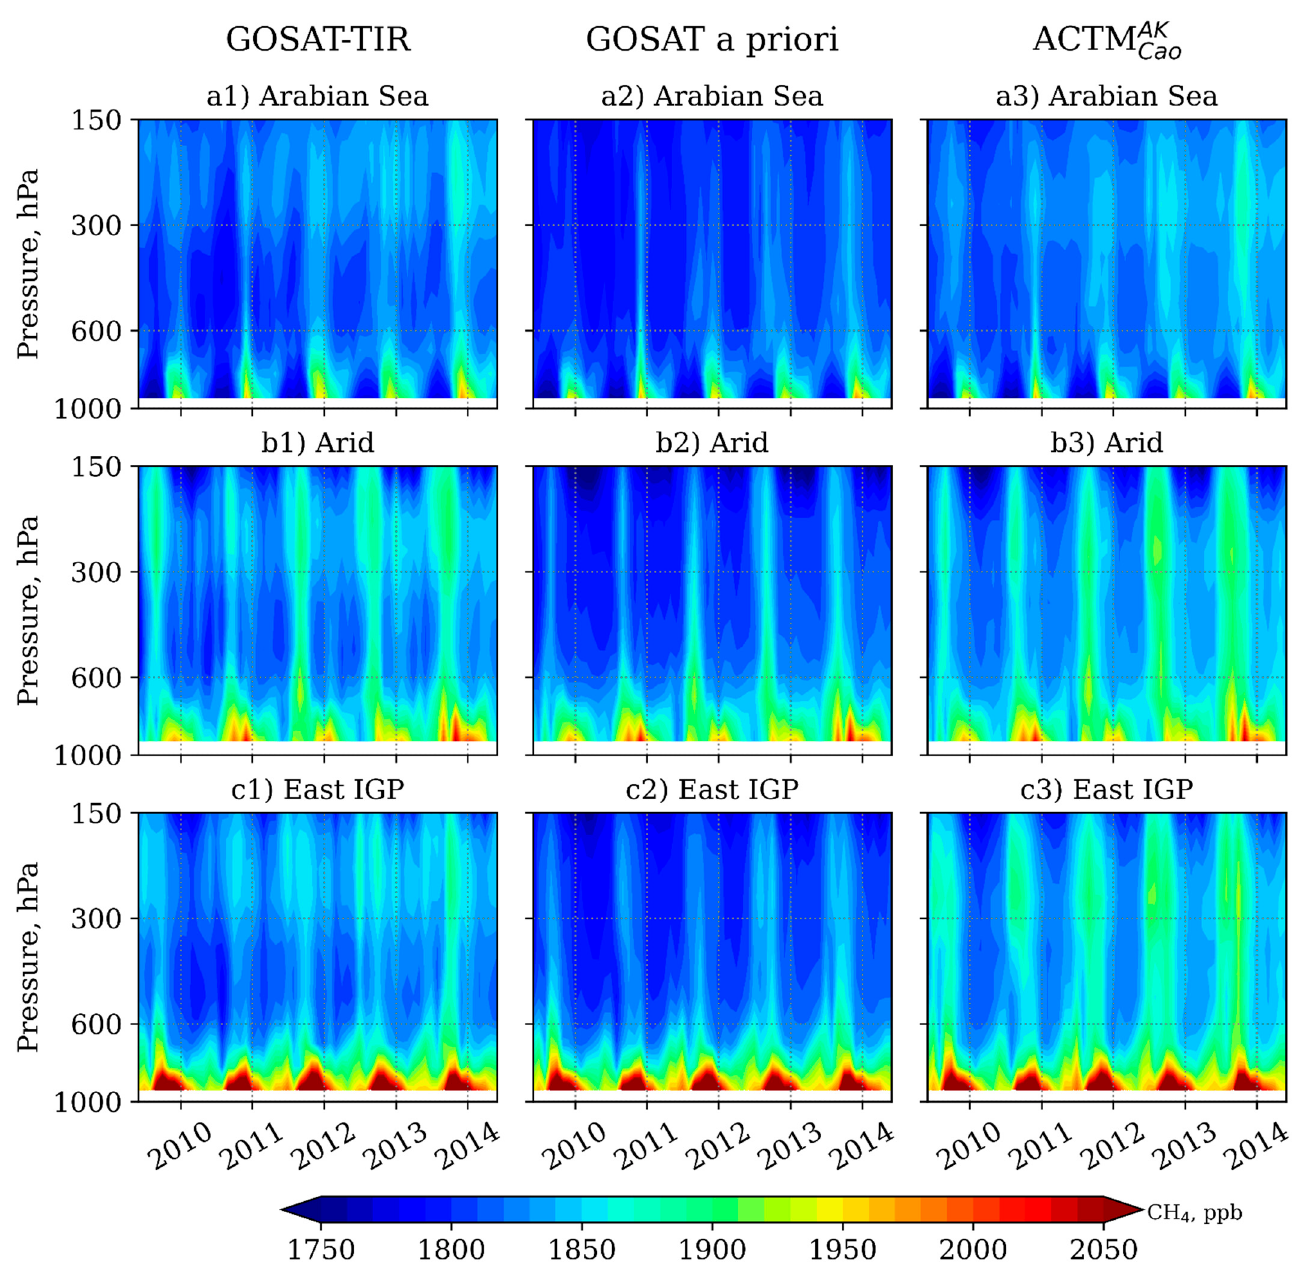
Figure 10. Time–altitude cross-section of CH 4 from GOSAT-TIR retrieval, GOSAT-TIR a priori, and ACTM AK (the left, middle, and right panels, respectively) for the Arabian Sea, Arid, and EIGP regions (for all regions please see Figure S7). Note that the profiles are shown for the tropospheric altitudes because the GOSAT-TIR retrieval system is not sensitive to the stratospheric altitudes (see Figure 8 and the associated text).